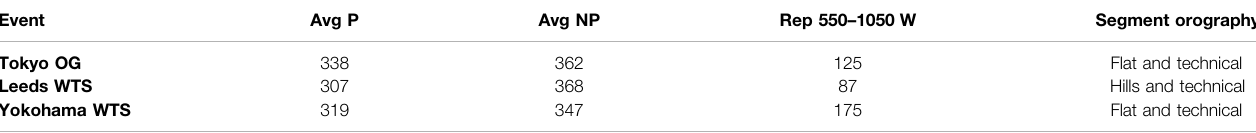
TABLE 5 | The power pro fi le in the cycling segment of the races during the season 2021. Event Avg P Avg